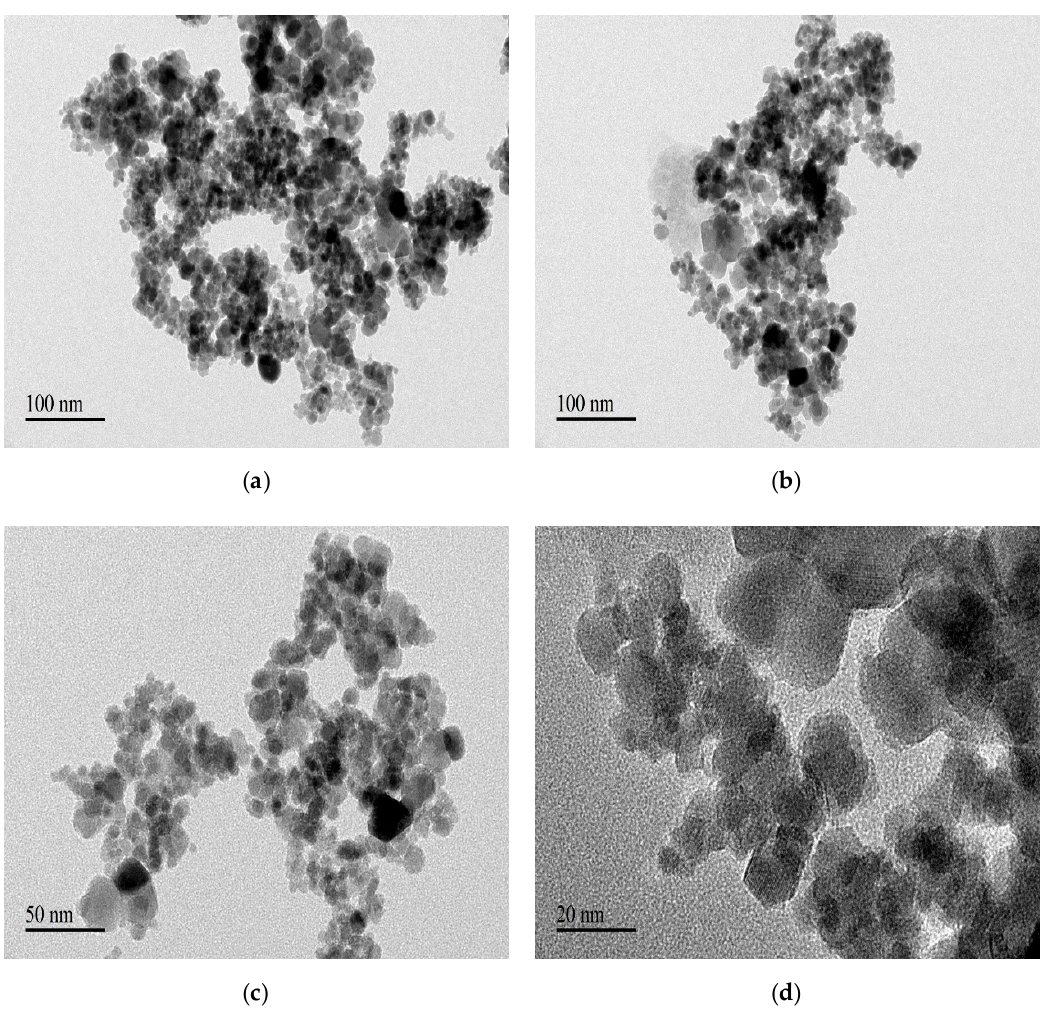
Figure 6. The comparison of TEM images of C-AgNPs at various magnifications showing morphology and particle size distribution.